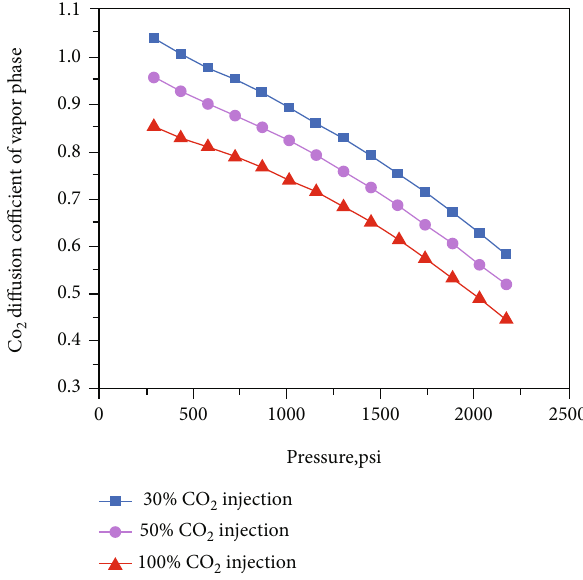
Figure 19: CO di ff usion coe ffi cient of vapor phase for the Bakken 2 tight oil versus pressure at various CO injections at T = 230 ° 2